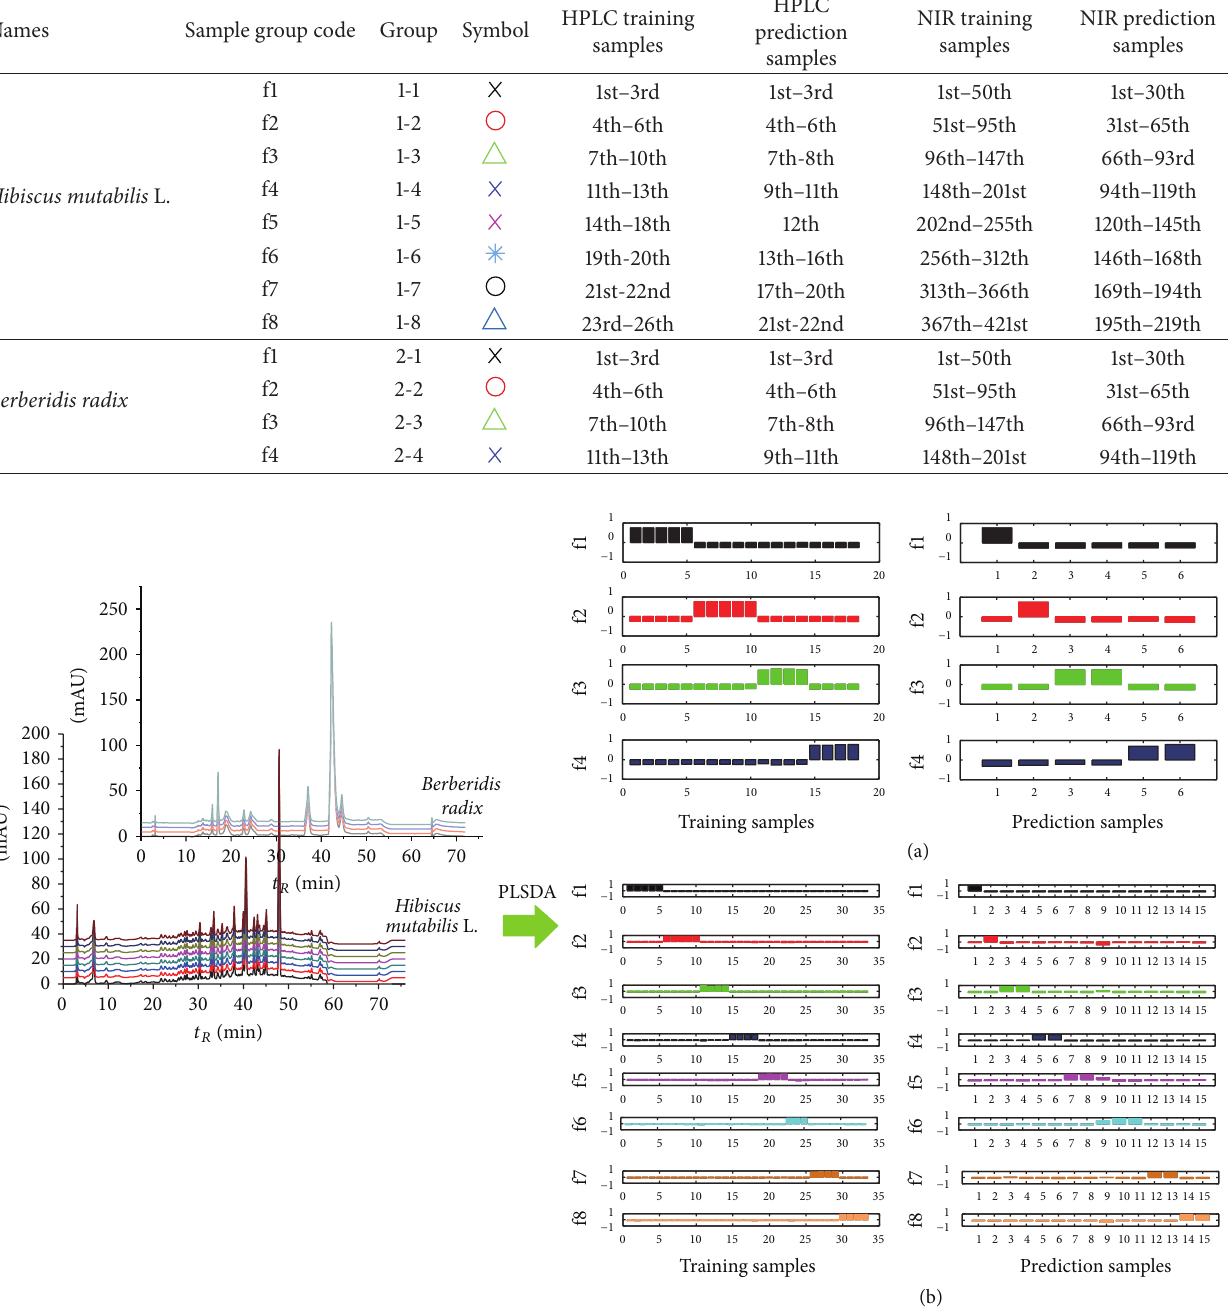
Table 2: A detailed list of Hibiscus mutabilis L. and Berberidis radix information.